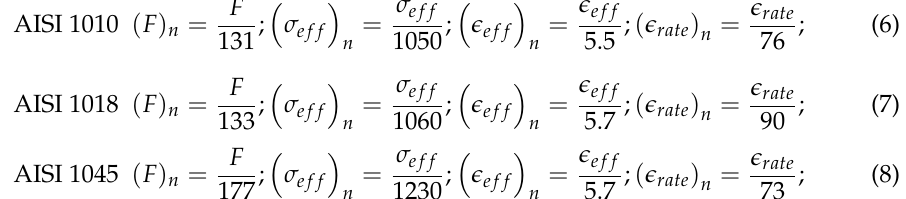
Table 5. Punch and billet sizes according to DE Optimal control factors for AISI 1010 steel.